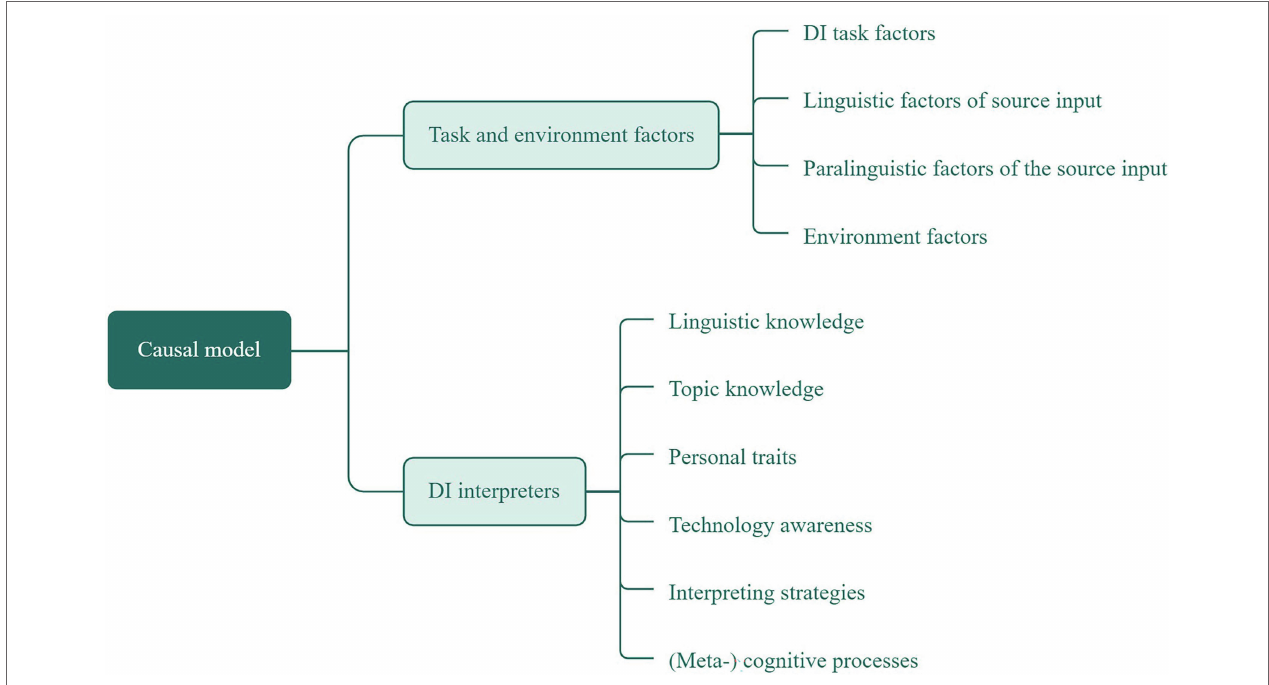
FIGURE 2 | Causal factors that induce change in interpreters’ cognitive load during